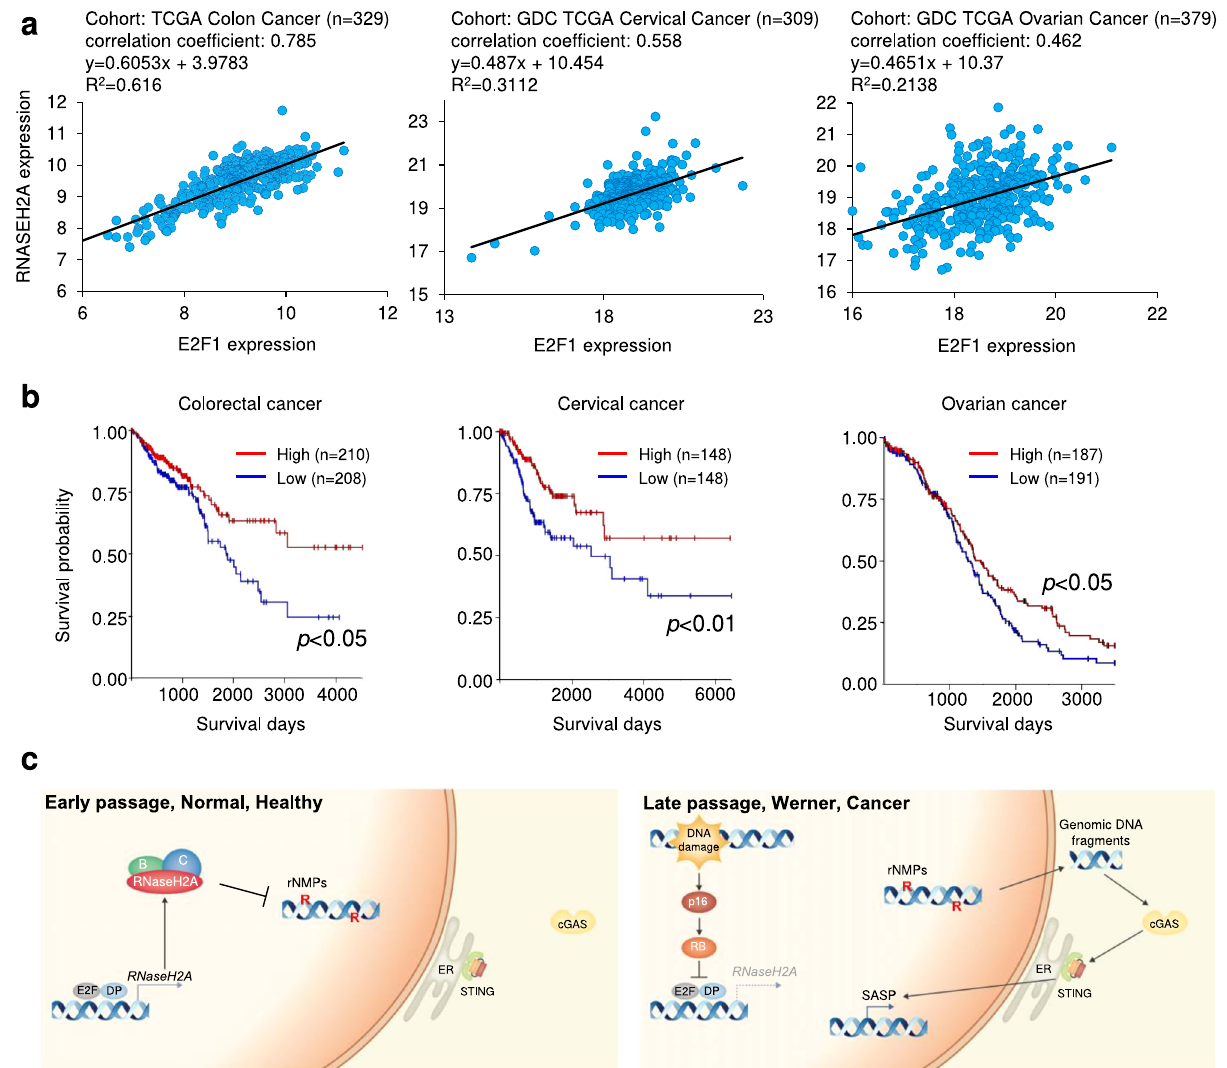
Fig. 8 Low RNaseH2A expression is associated with poor prognoses in cancer. a Plots of RNASEH2A and E2F1 mRNA expression levels in tissues derived from patients with colon ( n = 329), cervical ( n = 309) and ovarian ( n = 379) cancers from TCGA database. The correlation between E2F1 expression and RNASEH2A expression was evaluated by Pearson ’ s correlation coef fi cient. b Comparison of overall survival time between patients with low expression of RNaseH2A (blue) and those with high expression (red) in colorectal ( n = 418), cervical ( n = 296) and ovarian ( n = 378) cancers from TCGA database. Log-rank test. c Outline the diagram of this